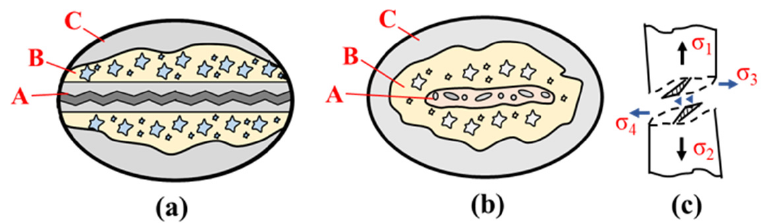
Figure 14. Schematic diagram of the fracture morphology distribution: ( a ) quasi-cleavage fracture; ( b ) quasi-cleavage fracture with few brittleness characteristics; ( c ) schematic diagram of the fracture. (A, B, and C represent the crack origin area, radiation area, and fracture area, respectively, i.e., the three areas of the cross section from inside to outside; σ 1 , σ 2 , σ 3 and σ 4 mean different directions of different stress).